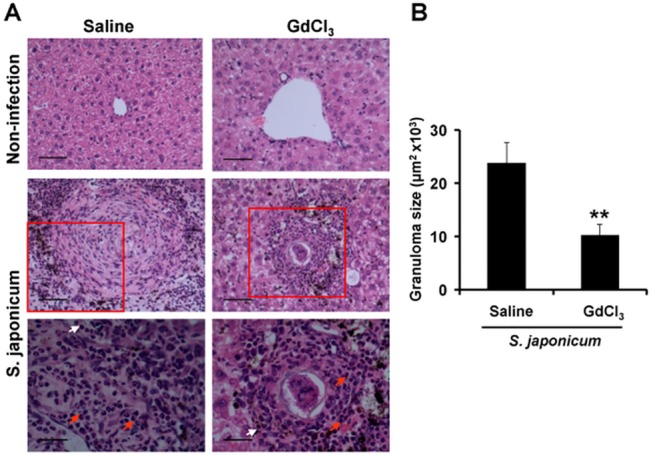
Repeated injection of GdCl3 attenuates S. japonicum egg-induced hepatic granuloma inflammation.Liver sections were stained with H&E (A) for eosinophils (red arrow) and lymphocytes (white arrow) (Original magnification, top and middle row ×200,bar scale 50 μm, bottom row ×400,bar scale 25 μm) or average granuloma sizes (B). Means and SD are shown. **
P<0.01.